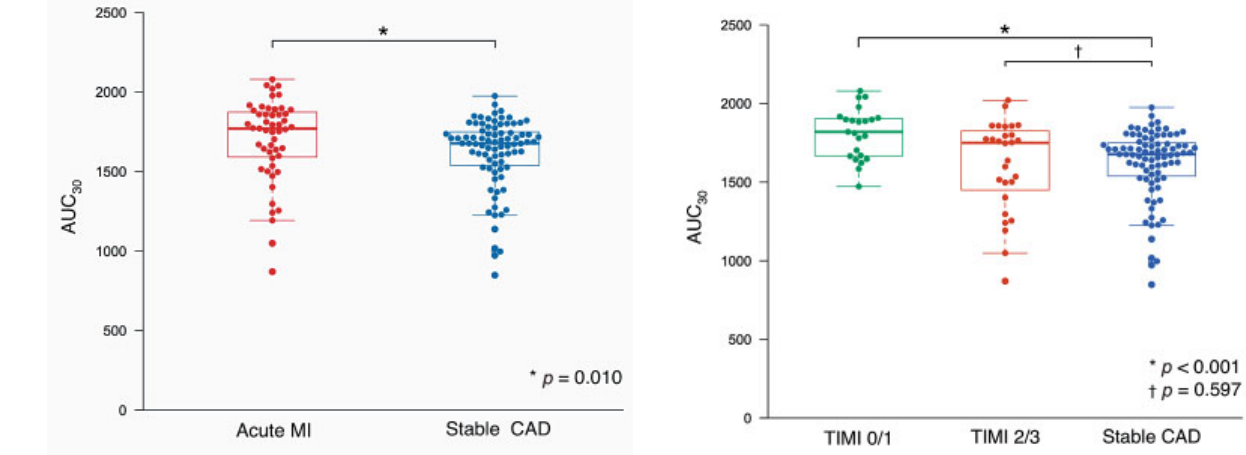
Fig. 2 Comparison of blood thrombogenicity by initial TIMI fl ow grade in acute MI. Acute MI patients with initial TIMI 0/1 fl ow grade had signi fi cantly higher AUC 30 levels than stable CAD patients (1,852 [1,661 – 1,910] vs. 1,677 [1,527 – 1,756], p < 0.001), whereas there was no signi fi cant difference in AUC 30 levels between acute MI patients with initial TIMI 2/3 fl ow grade and stable CAD patients (1,748 [1,450 – 1,826] vs. 1,677 [1,527 – 1,756], p ¼ 0.597). CAD, coronary artery disease; MI, myocardial infarction.